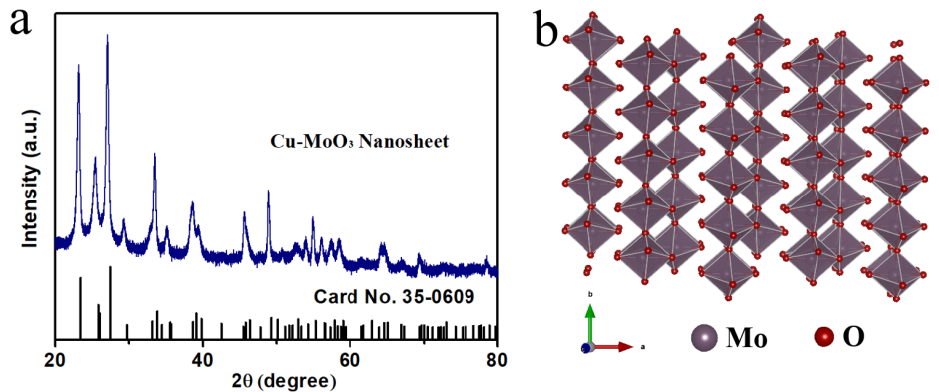
Figure 1. ( a ) The XRD pattern of Cu doped MoO 3 nanosheet and ( b ) the crystal structure of MoO 3 sample.